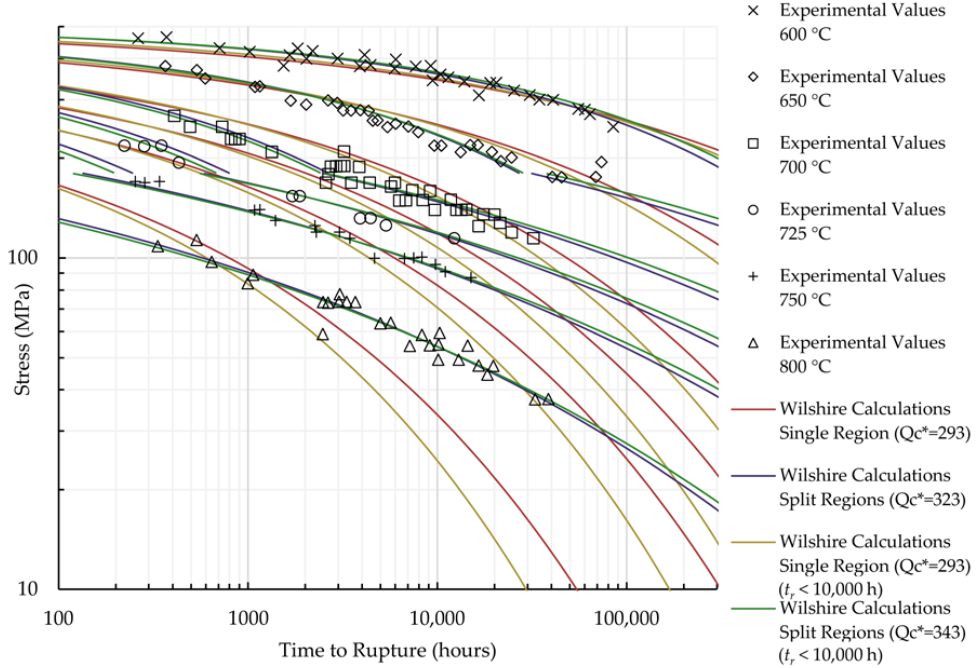
Figure 6. Calculations of the Wilshire equation with the lowest error for Sanicro 25.